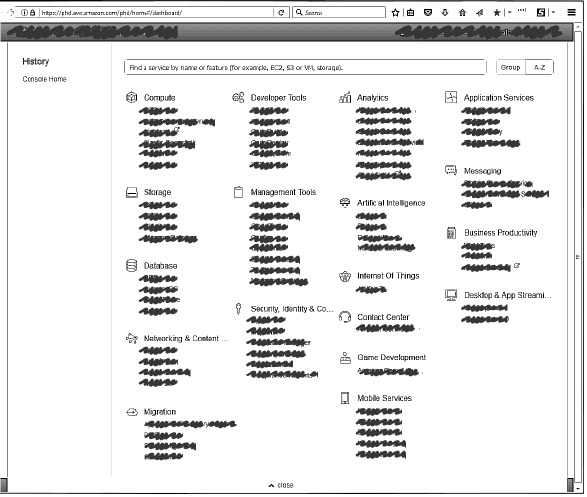
Fig. 12. Amazon Elastic Beanstalk dashboard with a listing of available